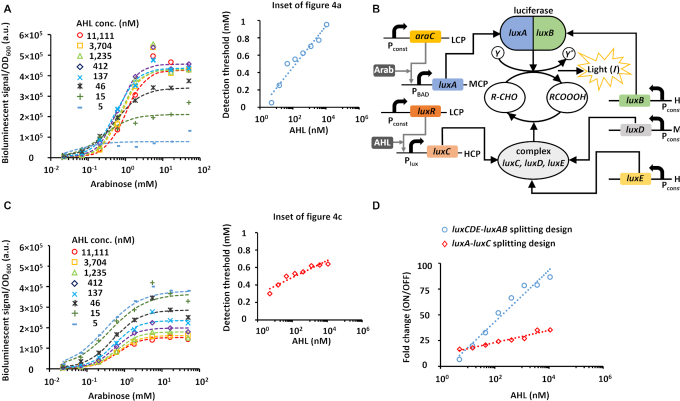
Design of a synthetic comparator with a programmable detection threshold in living cells by splitting the luxCDABE cassette. (A) Measured transfer function between Arabinose input concentration and bioluminescent signal, for varying acyl-homoserine-lactone (AHL) levels. These data were extracted from Figure 3C. The dots represent the experimental results and the dashed lines fit Hill function curves (see Section 2, Supplementary Table S5 of the Supplementary Data for parameters used for fitting). The inset shows the relationship between the detection threshold (\documentclass[12pt]{minimal}
\usepackage{amsmath}
\usepackage{wasysym}
\usepackage{amsfonts}
\usepackage{amssymb}
\usepackage{amsbsy}
\usepackage{upgreek}
\usepackage{mathrsfs}
\setlength{\oddsidemargin}{-69pt}
\begin{document}
}{}${K_{deff}}$\end{document}) and AHL concentration. \documentclass[12pt]{minimal}
\usepackage{amsmath}
\usepackage{wasysym}
\usepackage{amsfonts}
\usepackage{amssymb}
\usepackage{amsbsy}
\usepackage{upgreek}
\usepackage{mathrsfs}
\setlength{\oddsidemargin}{-69pt}
\begin{document}
}{}${K_{deff}}$\end{document} was calculated as the input value corresponding to half of the output value. (B) Design by further splitting the luxCDABE cassette. The luxC is regulated by the Plux promoter located on a high copy number plasmid (HCP). LuxR is regulated by a constitutive promoter located on a low copy number plasmid (LCP) and is induced by AHL to activate Plux. The luxA is regulated by the PBAD promoter located on a medium copy number plasmid (MCP). AraC is regulated by a constitutive promoter located on a LCP and is induced by Arabinose to activate PBAD. The luxD is regulated by a constitutive promoter located on MCP. The luxB and luxE are regulated by a constitutive promoter located on an HCP. (C) Measured transfer function between Arabinose input concentration and bioluminescence signal for varying AHL levels. The dots represent the experimental results and the dashed lines fit Hill function curves (see Section 2, Supplementary Table S5 of the Supplementary Data for parameters used for fitting). The inset shows the relationship between the detection threshold (\documentclass[12pt]{minimal}
\usepackage{amsmath}
\usepackage{wasysym}
\usepackage{amsfonts}
\usepackage{amssymb}
\usepackage{amsbsy}
\usepackage{upgreek}
\usepackage{mathrsfs}
\setlength{\oddsidemargin}{-69pt}
\begin{document}
}{}${K_{deff}}$\end{document}) and AHL concentrations. The \documentclass[12pt]{minimal}
\usepackage{amsmath}
\usepackage{wasysym}
\usepackage{amsfonts}
\usepackage{amssymb}
\usepackage{amsbsy}
\usepackage{upgreek}
\usepackage{mathrsfs}
\setlength{\oddsidemargin}{-69pt}
\begin{document}
}{}${K_{deff}}$\end{document} was calculated as the input value corresponding to half of the output value. (D) Fold change comparison (ON/OFF ratio) for luxCDE-luxAB (data based on A, Supplementary Table S6) and the new design by further luxA-luxC splitting of the luxCDABE cassette (data based on C, Supplementary Table S7). All experimental data represent the average of three experiments. Further statistical analysis is provided in Section 2 of the Supplementary Data.